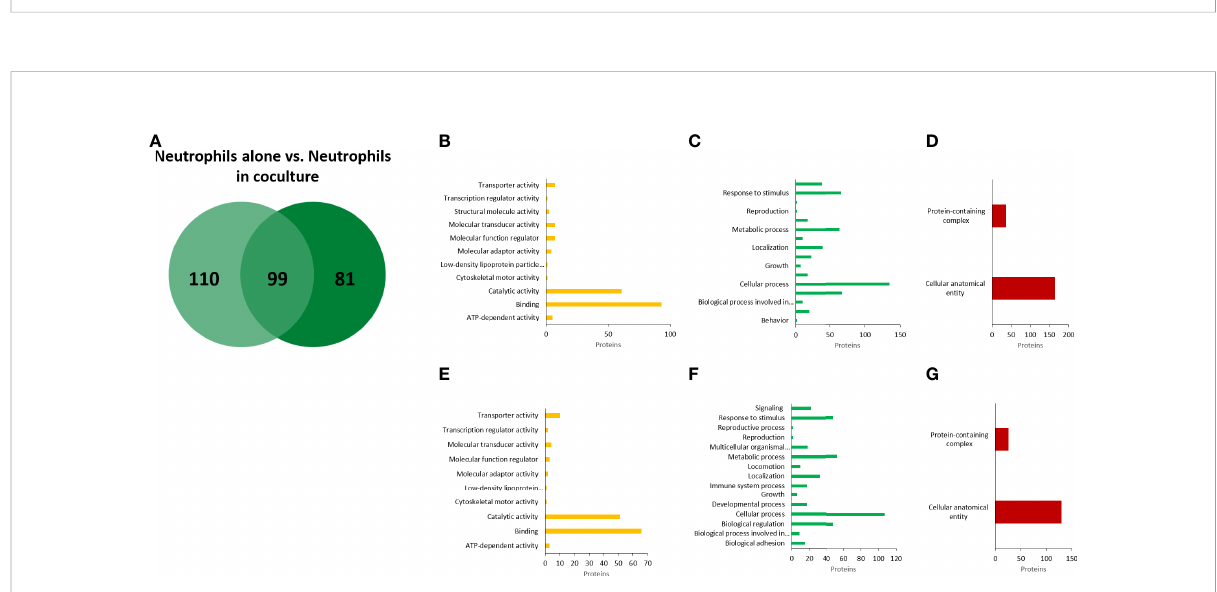
FIGURE 7 Proteomic analysis of EVs released from human neutrophils. Venn diagram of comparted proteins between neutrophils culture alone and neutrophils cocultured with amoebae (A) . Gene ontology (GO) analysis performed in PANTHER GO of molecular function (B) , biological processes (C) , and cellular components (D) of EVs proteins from neutrophils alone. (E – G) , similar analysis of EVs proteins from neutrophils in coculture.